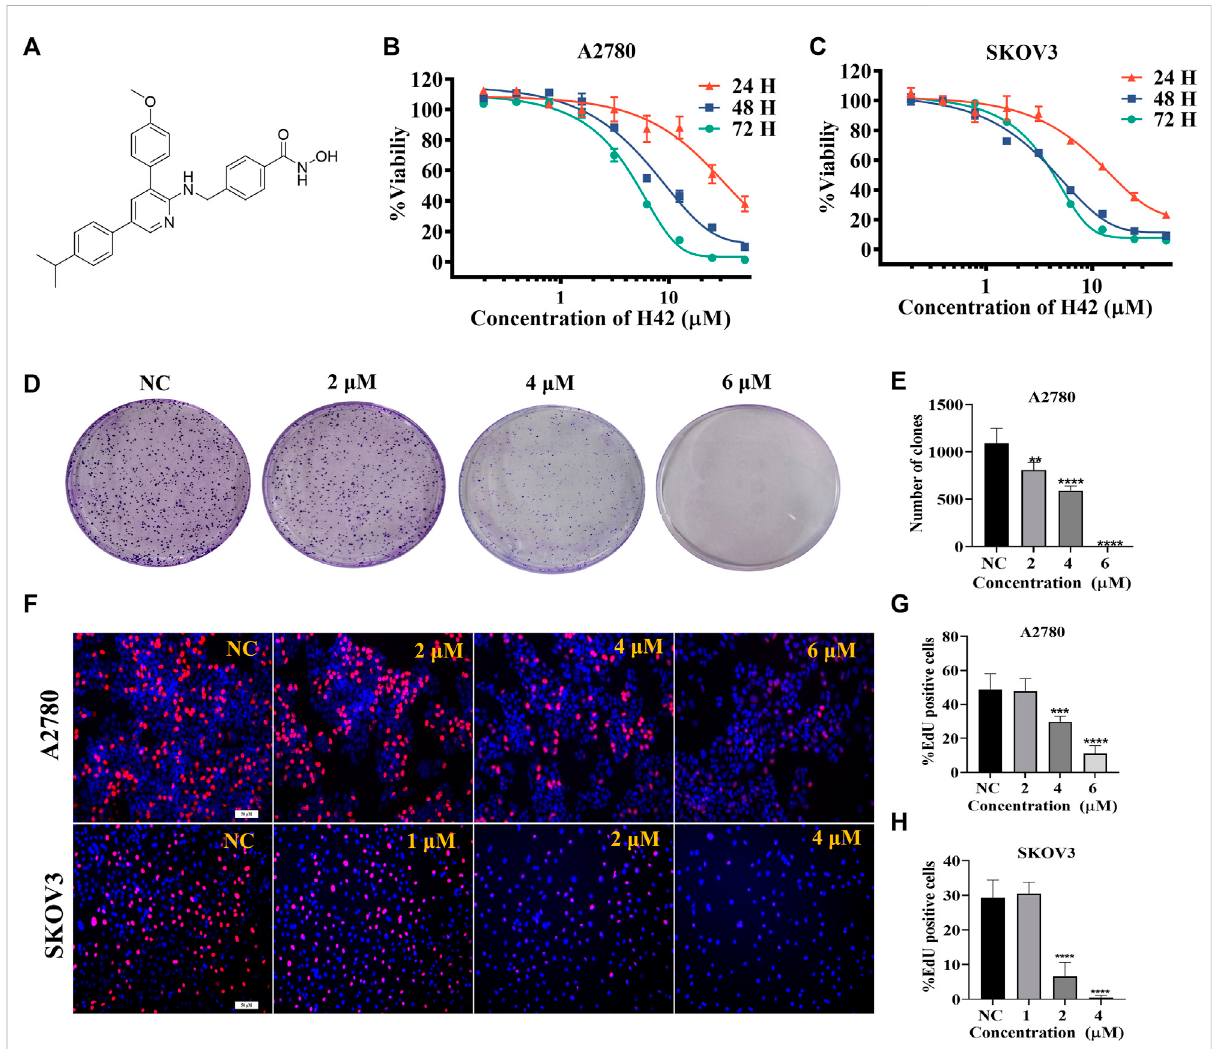
Compound H42 inhibited ovarian cancer cell proliferation in vitro . (A) Structure of compound H42. The effect of compound H42 in A2780 (B) and SKOV3 (C) cells in 24, 48, and 72 H was detected by CCK-8. (D) Colony formation of A2780 cells treated with different concentrations of compound H42. (E) Analysis of colony numbers in various drug concentrations. (F) Proliferation of A2780 and SKOV3 cells was probed by EdU staining. Quanti fi cation of EdU-incorporated cells in A2780 (G) and SKOV3 (H) cells. Data are all represented as mean ± SD of at least